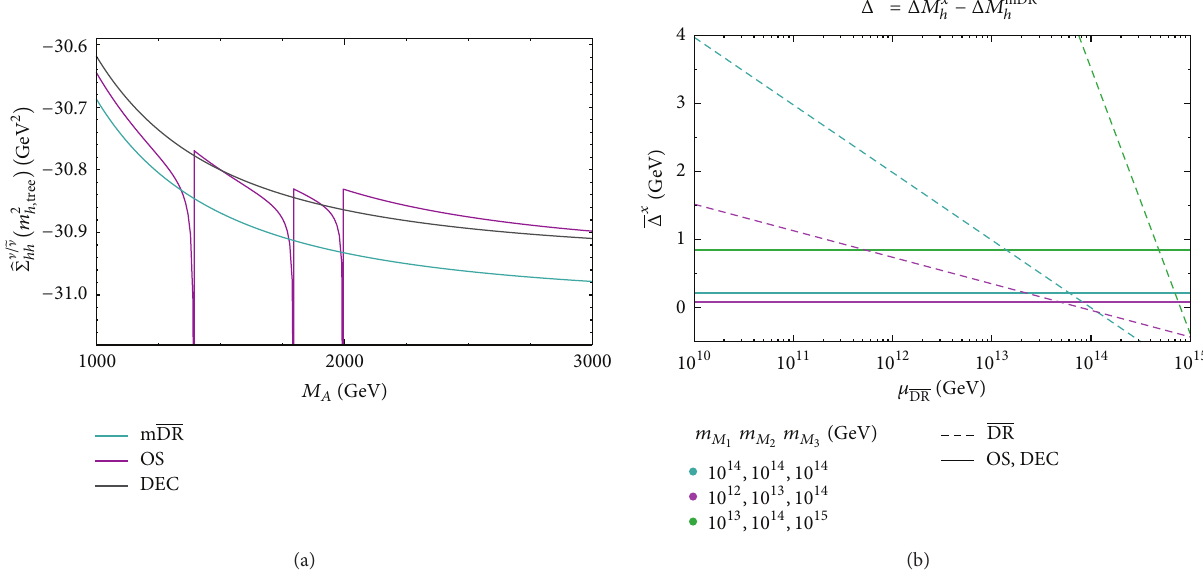
in the OS, DEC, and mDR tree and for several choices of the Majorana DR